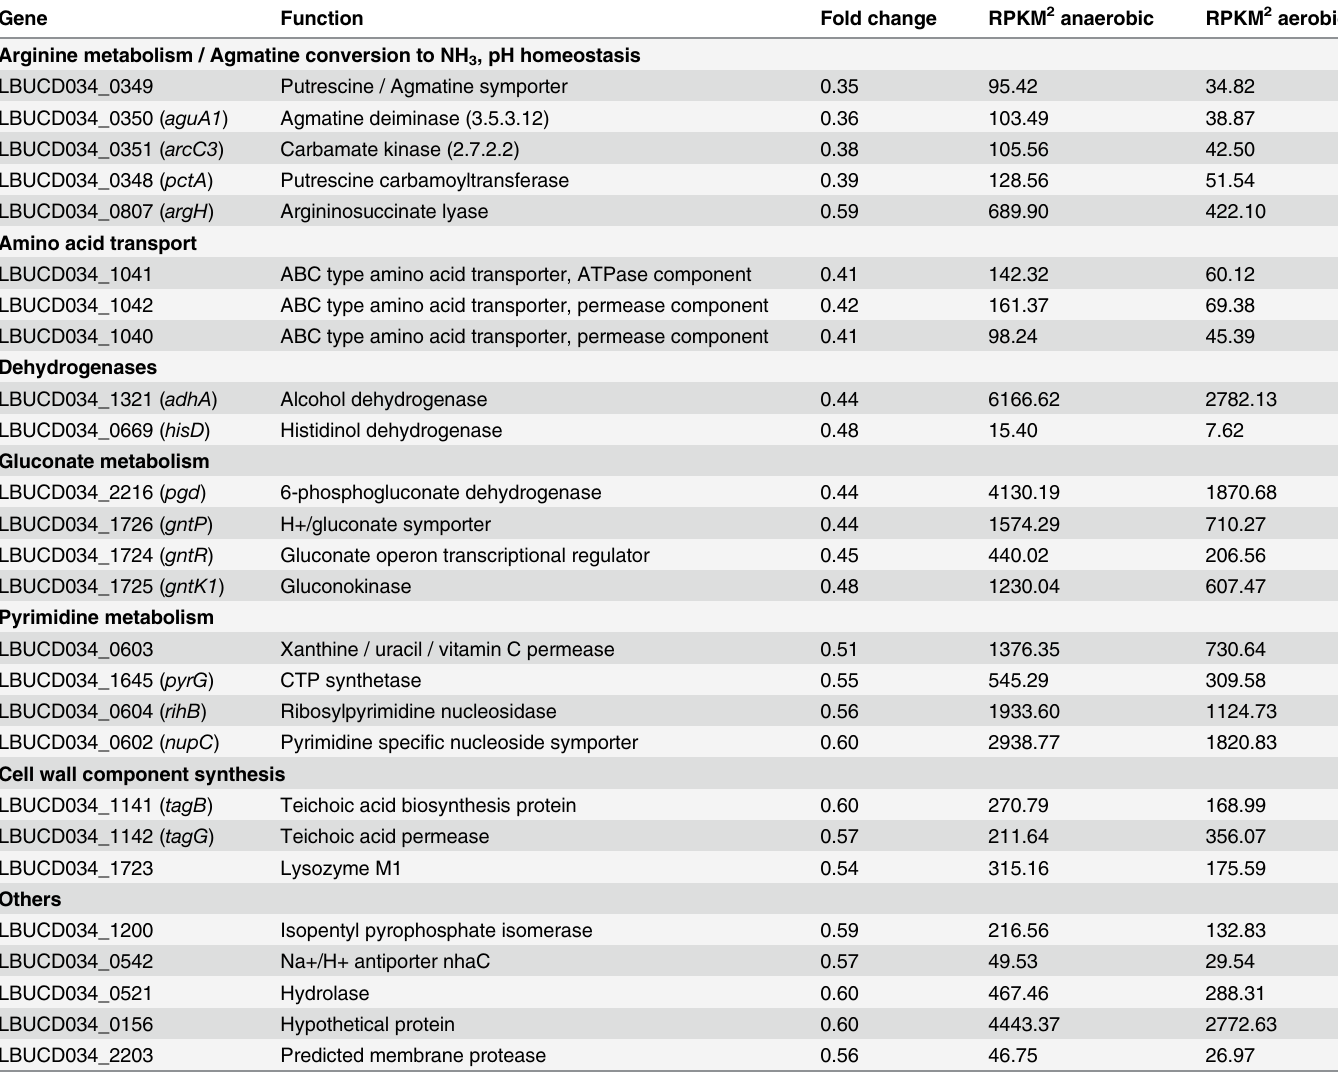
Table 4. Genes of L . buchneri CD034 found to be highly 1 down-regulated under aerobic vs . anaerobic conditions. Gene Function Fold